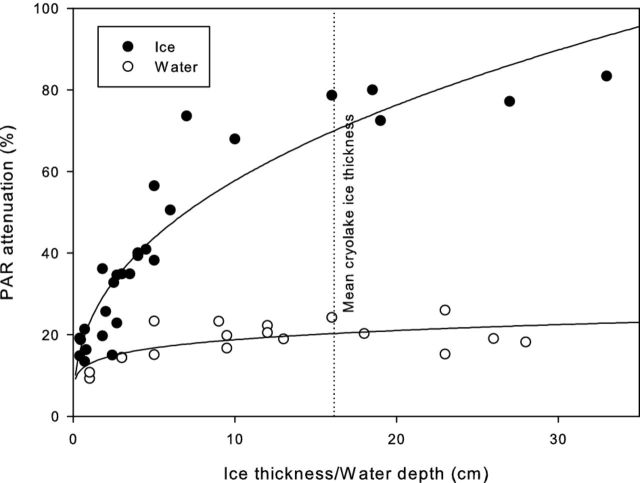
PAR attenuation (surface – subsurface) for ice lids of different thicknesses and with water depth on Joyce Glacier. Regression fit between ice thickness and PAR attenuation is PAR = 22.9 hi0.40, r2 = 0.87 and water depth and PAR attenuation is PAR = 12.9 hw0.14, r2 = 0.44.